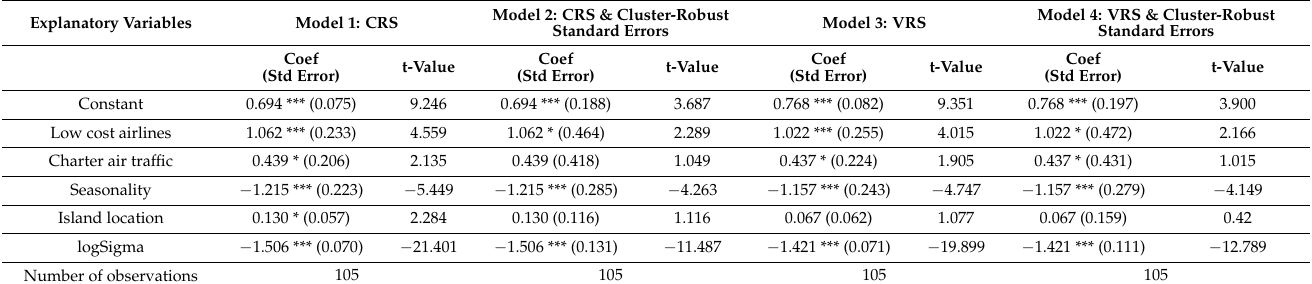
Table 6. Estimation results of the tobit regression